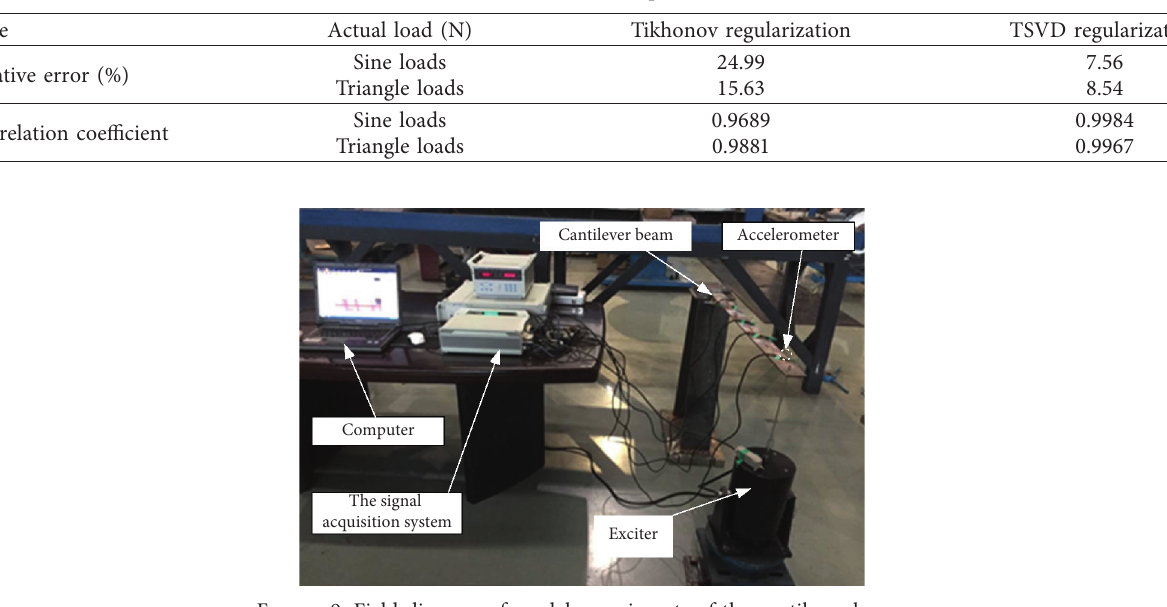
Table 3: Identification results at five time points below 5% noise level.